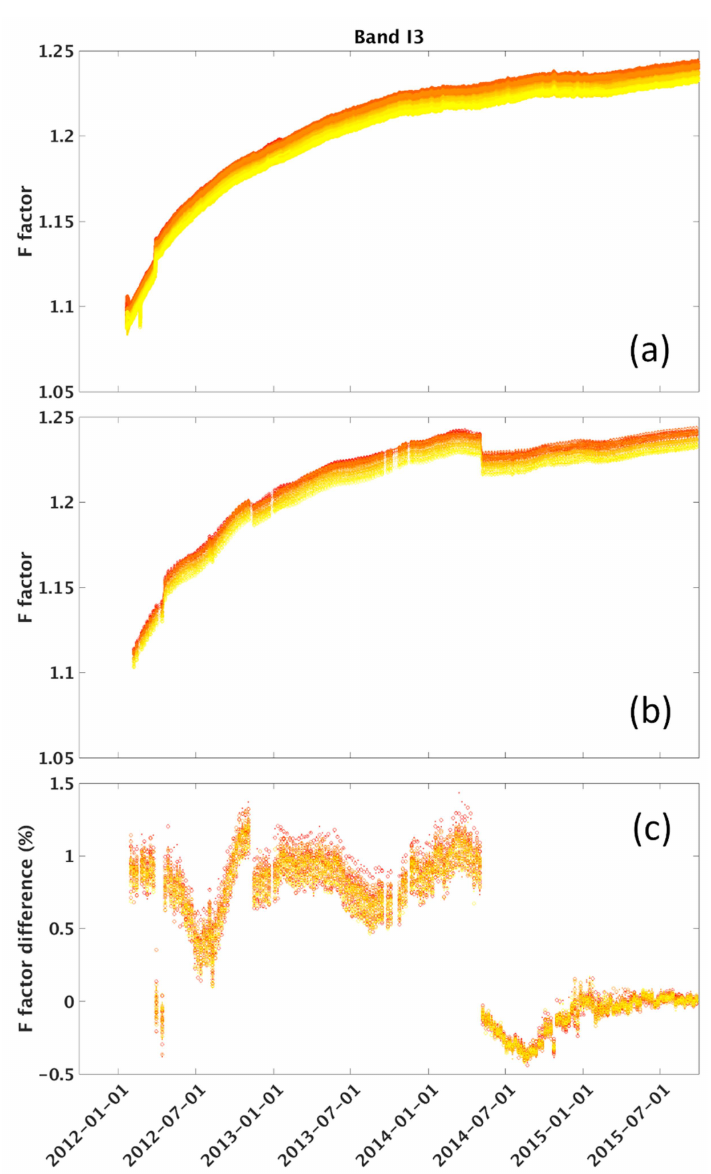
Figure 7. ( a ) VIIRS band I3 (1610 nm, single gain) radiometric calibration scaling coefficients (the F factors) derived by the automated calibration procedure; ( b ) the F factors used in the operational production of the VIIRS SDR; and ( c ) relative difference between the operational F factors and the reprocessed ones (used here as a baseline). Symbol legend is the same as in Figure 4. The SWIR (short-wave infrared) bands (I3 and M8–M11) also show an F factor discontinuity in March 2012. This reflects an actual gain change that occurred after the Suomi NPP spacecraft was temporarily in safe mode during which the spacecraft was oriented toward the Sun. After this gain change, the reprocessed F factors are updated sooner by the automated calibration procedure than they were during the original operational processing. This creates the spikes in the differences between the reprocessed and operational F factors for the SWIR bands, and it also shows once more that the automated calibration procedure improves upon the operational processing. A downward spike in the reprocessed SWIR-band F factors occurs in February 2012 during an orbital pitch maneuver of the Suomi NPP spacecraft. During the pitch maneuver, SWIR detectors temperature briefly increased above the nominal level, and the SWIR bands gains changed. Solar